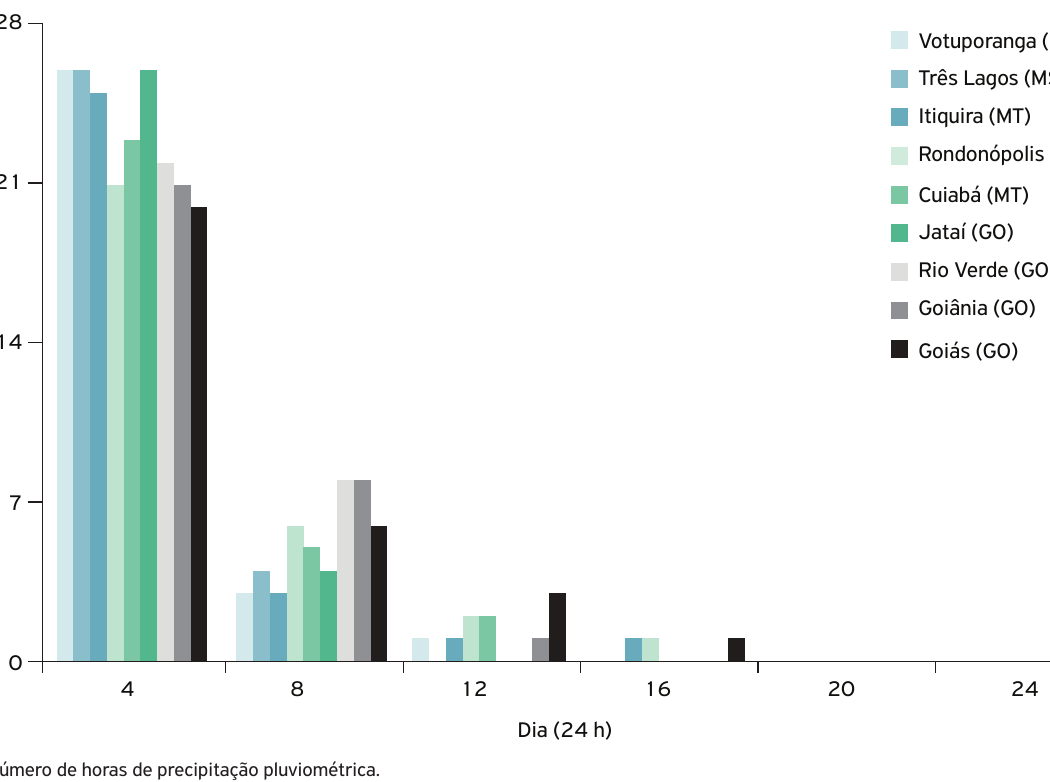
Figura 4. Distribuição da frequência diária do número de horas de precipitação pluviométrica igual ou maior que 1 mm, no período entre 12 de janeiro e 10 de fevereiro de 2013.